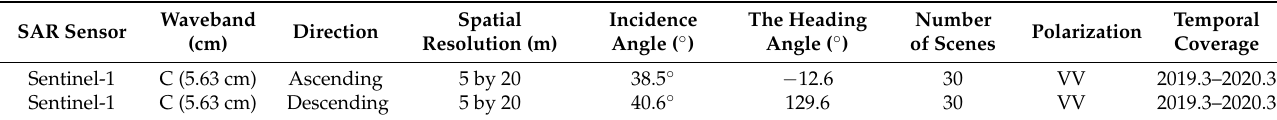
Table 1. Parameters of radar image data used in the study.